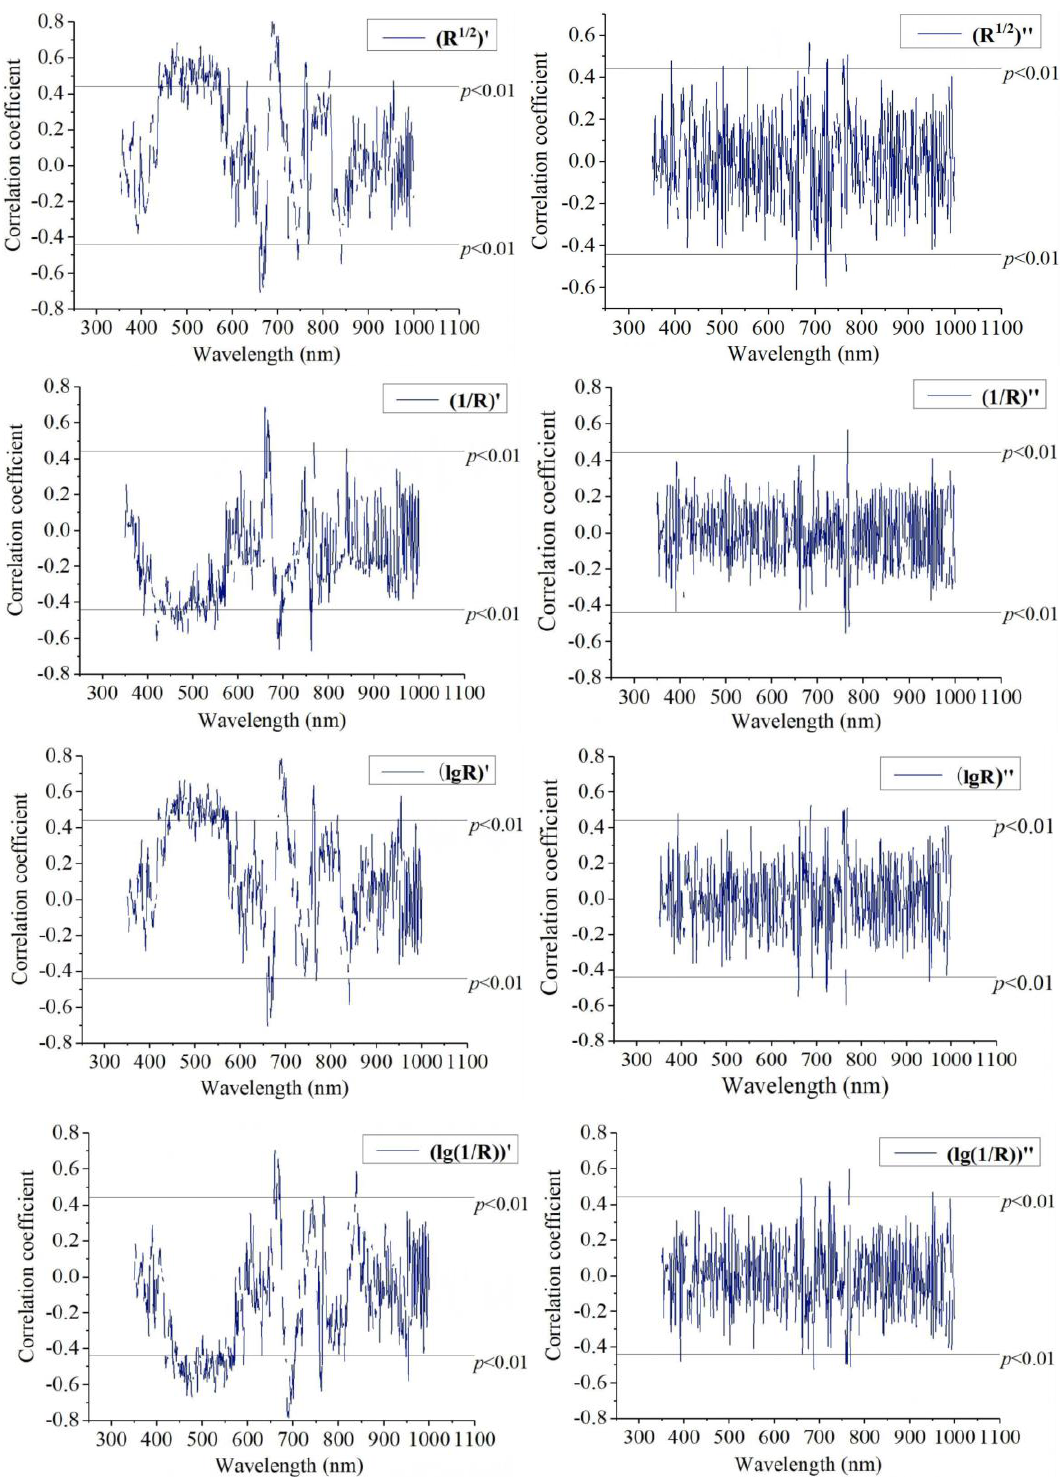
Figure 3. Search for the hyperspectral sensitive band under the spectral transformation.